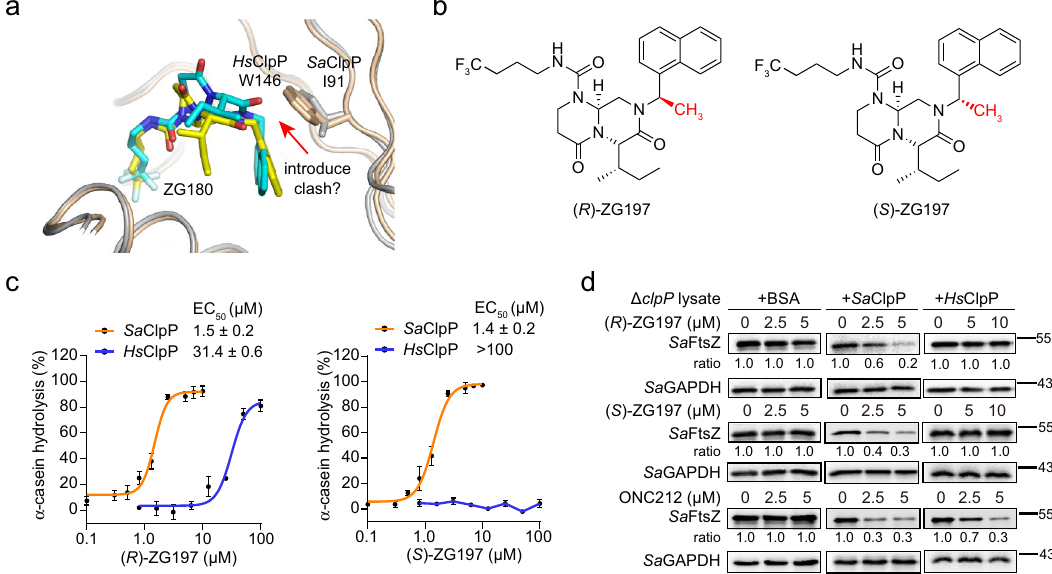
Fig. 2 | Design and development of selective Sa ClpP activators. a Structural superimposition of ZG180/ Sa ClpP and ZG180/ Hs ClpP complexes to reveal the strategy for designing selective activators for Sa ClpP over Hs ClpP. Sa ClpP and Hs ClpP are shown in gray and wheat cartoon tubes, respectively. ZG180 is colored in cyan in the ZG180/ Sa ClpP structure, while it is colored in yellow in the ZG180/ Hs ClpP structure. I91 in Sa ClpP and W146 in Hs ClpP are shown as a stick. b Structures of Sa ClpP activators ( R )- and ( S )-ZG197 developed by the structure- based design outlined in ( a ). The chiral methyl group is indicated in red. c Quantitation of α -casein hydrolysis by Sa ClpP and Hs ClpP in the presence of ( R )-